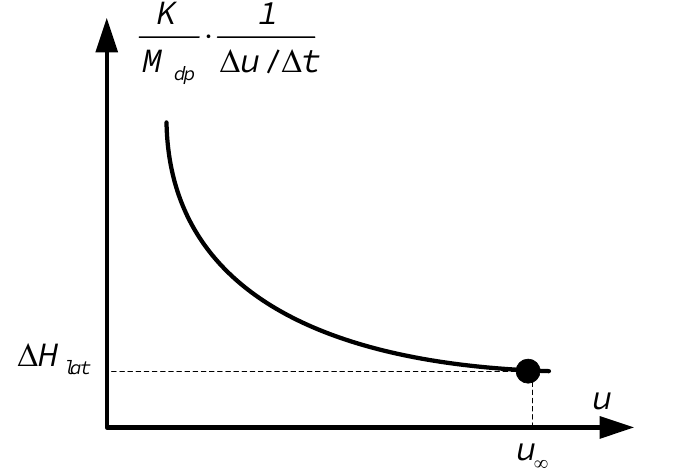
Figure 2. Determination of model parameter K / M dp.